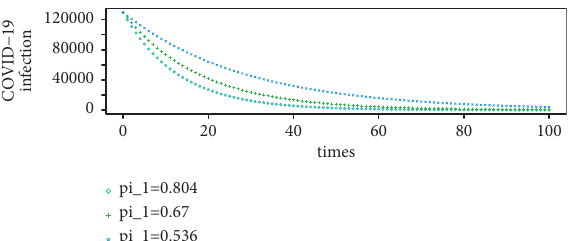
Figure 6: Simulation of COVID-19 infection at different rates ( π finally 0.804, which is indicated by a leftward shift in COVID-19 infection from the right towards the origin.